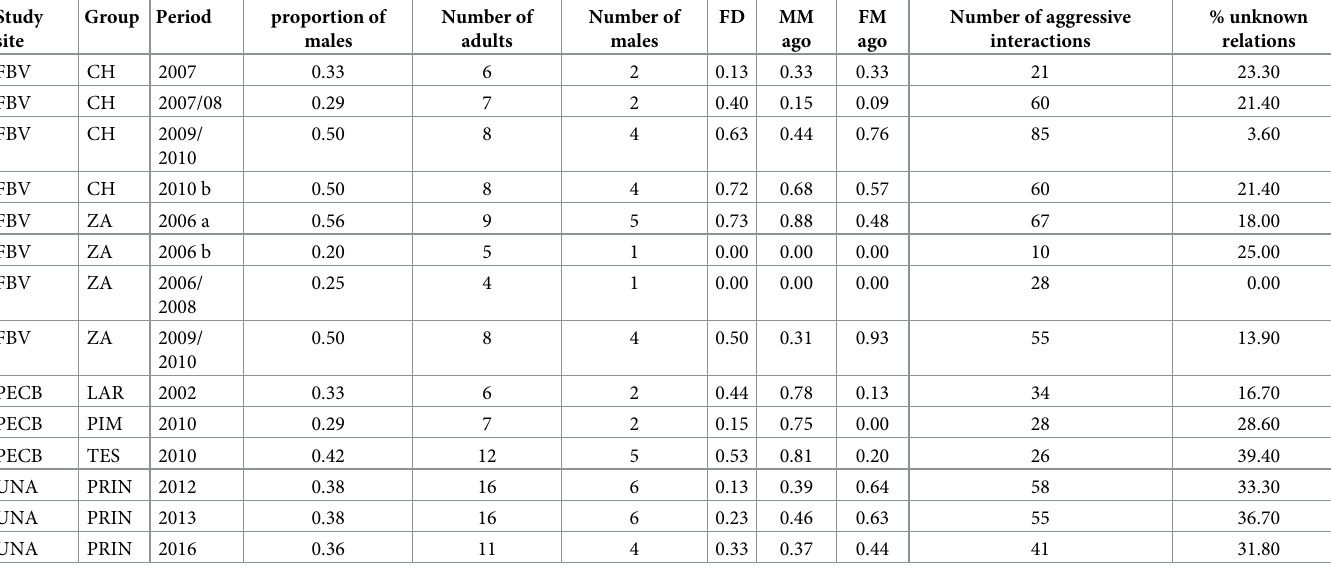
Table 3. Demography and dominance relations in empirical groups of robust capuchin monkeys. Study